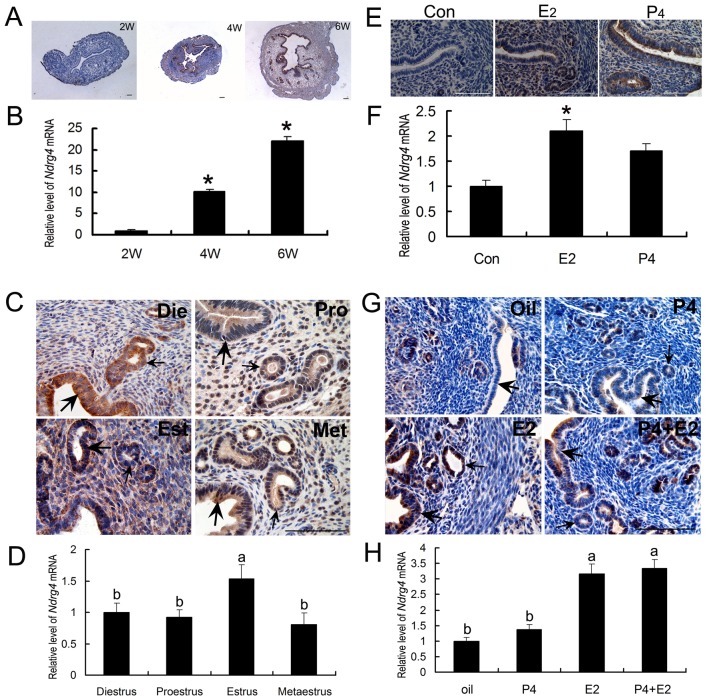
Effects of estrogen on uterine NDRG4 expression.(A) Immunohistochemical analysis of uterine NDRG4 expression during the different postnatal development stages, 2W, 2-weeks old; 4W, 4-weeks old; 6W, 6-weeks old. (B) Quantitative PCR analysis of uterine NDRG4 mRNA expression during the different postnatal development stages (n = 3), *, significantly different (P < 0.05). (C) Immunohistochemical analysis of NDRG4 expression at the diestrus (Die), proestrus (Pro), estrous (Est) and metestrus (Met) phases during the estrous cycle. (D) Quantitative PCR analysis of uterine NDRG4 mRNA expression during the estrous cycle (n = 3), the thick arrow shows the luminal epithelium, the small arrow indicates the glandular epithelium, the columns with different superscripts are significantly different (P < 0.05). (E) Immunohistochemical analysis of uterine NDRG4 expression in prepuberty mice respectively treated by oil (Con), estrogen (E2) and progesterone (P4). One-week-old female mice (pre-pubertal stage) were divided into 3 groups (n = 3, per group) at random, and administered daily subcutaneous injections of (1) E2, (2) P4, or (3) sesame oil, respectively, for 7 days. (F) Quantitative PCR analysis of uterine NDRG4 mRNA expression in prepuberty mice following steroid hormone treatment (n = 3). *, significantly different (P < 0.05). (G) Immunohistochemical analysis of NDRG4 protein expression in ovariectomized mice respectively treated by oil (oil), progesterone (P4), estrogen (E2), and progesterone plus estrogen (P4+E2). (H) Quantitative PCR analysis of uterine NDRG4 mRNA expression in ovariectomized mice following steroid hormone treatment (n = 3). The thick arrow indicates the luminal epithelium. The small arrow shows the glandular epithelium. The columns with different superscripts are significantly different (P < 0.05).